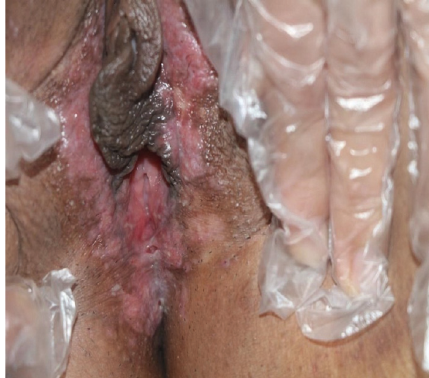
Figure 1: Pinkish mild erosions and small punched-out ulcers in genital area.